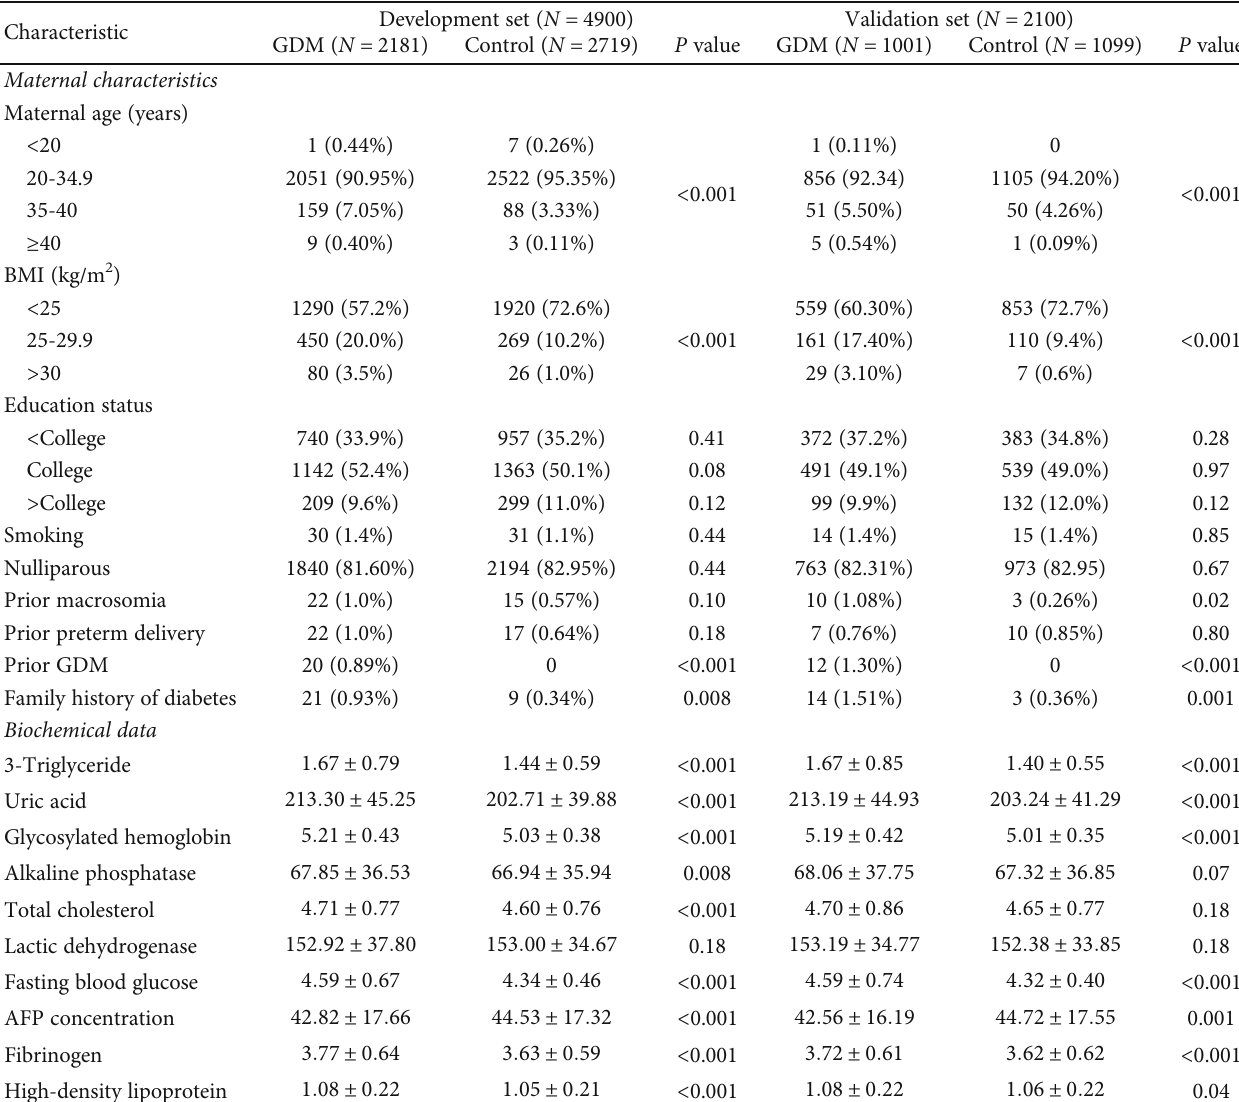
Table 1: Baseline